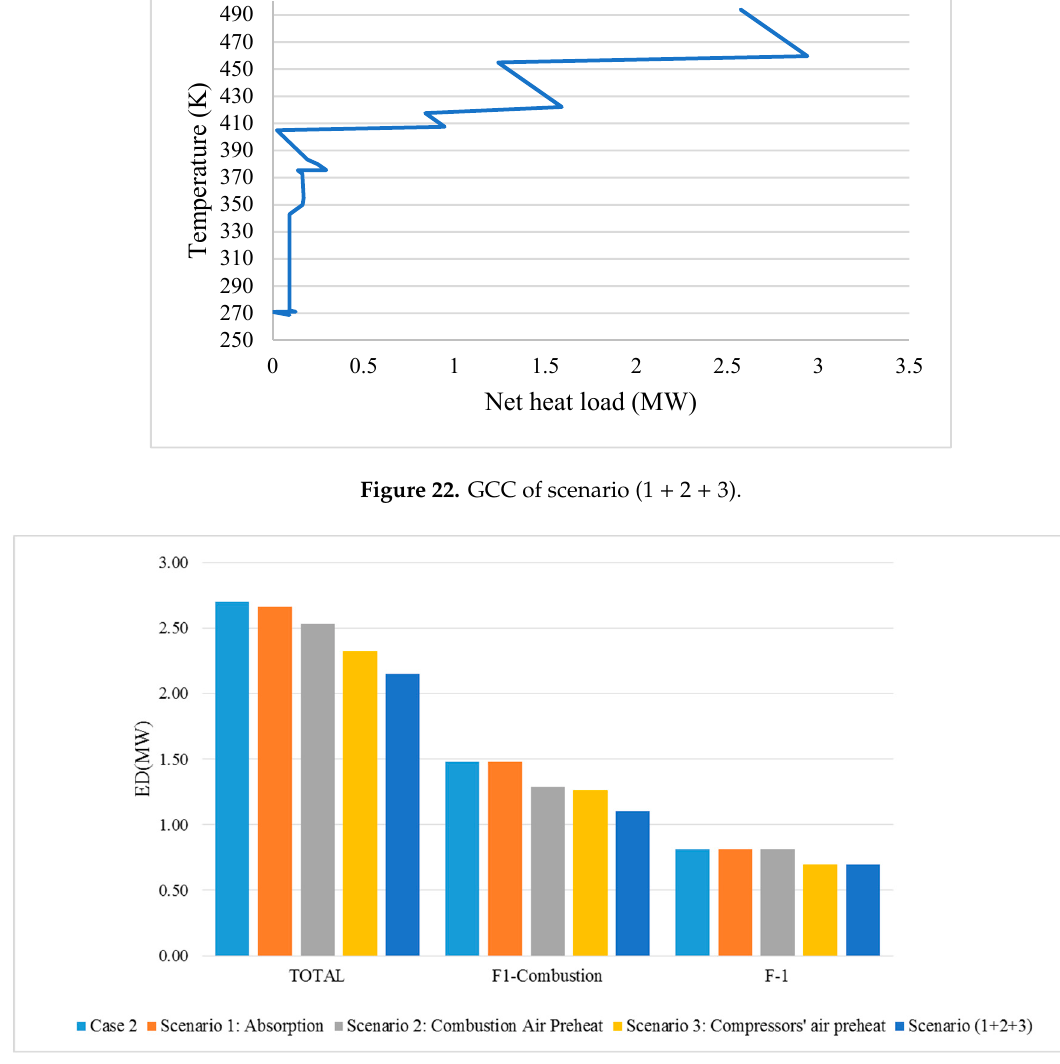
Figure 23. ED in the fired heater and total ED for the considered scenarios.